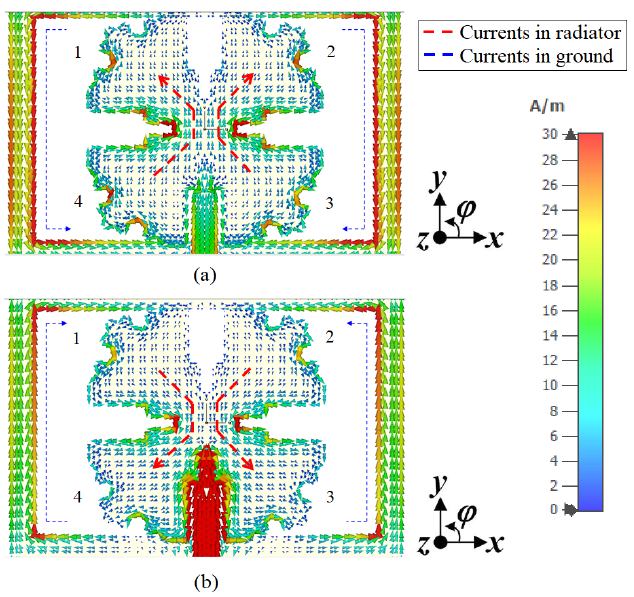
Figure 8. Surface current distributions on bow-tie shaped fractal radiator at ( a ) 2.45 GHz, (C-mode) and ( b ) 4.0 GHz, (L-mode).